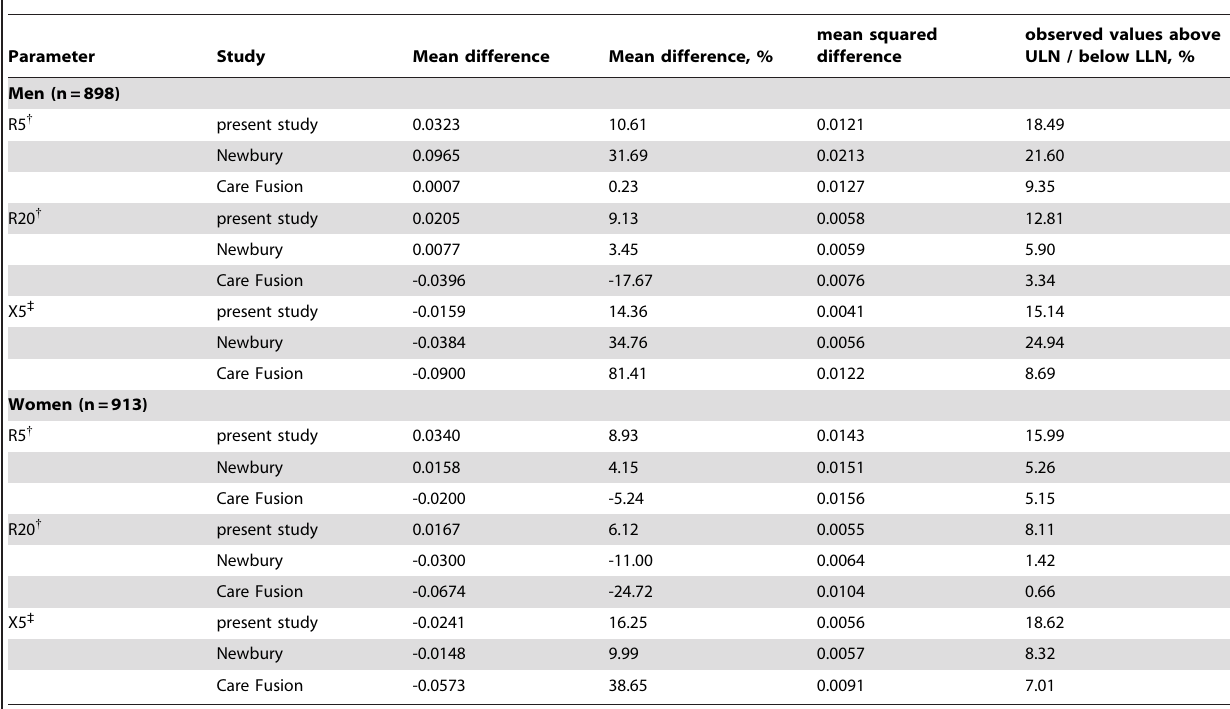
Table 6. Differences between observed values and predictions for the KORA-F4L and KORA-AGE study population.